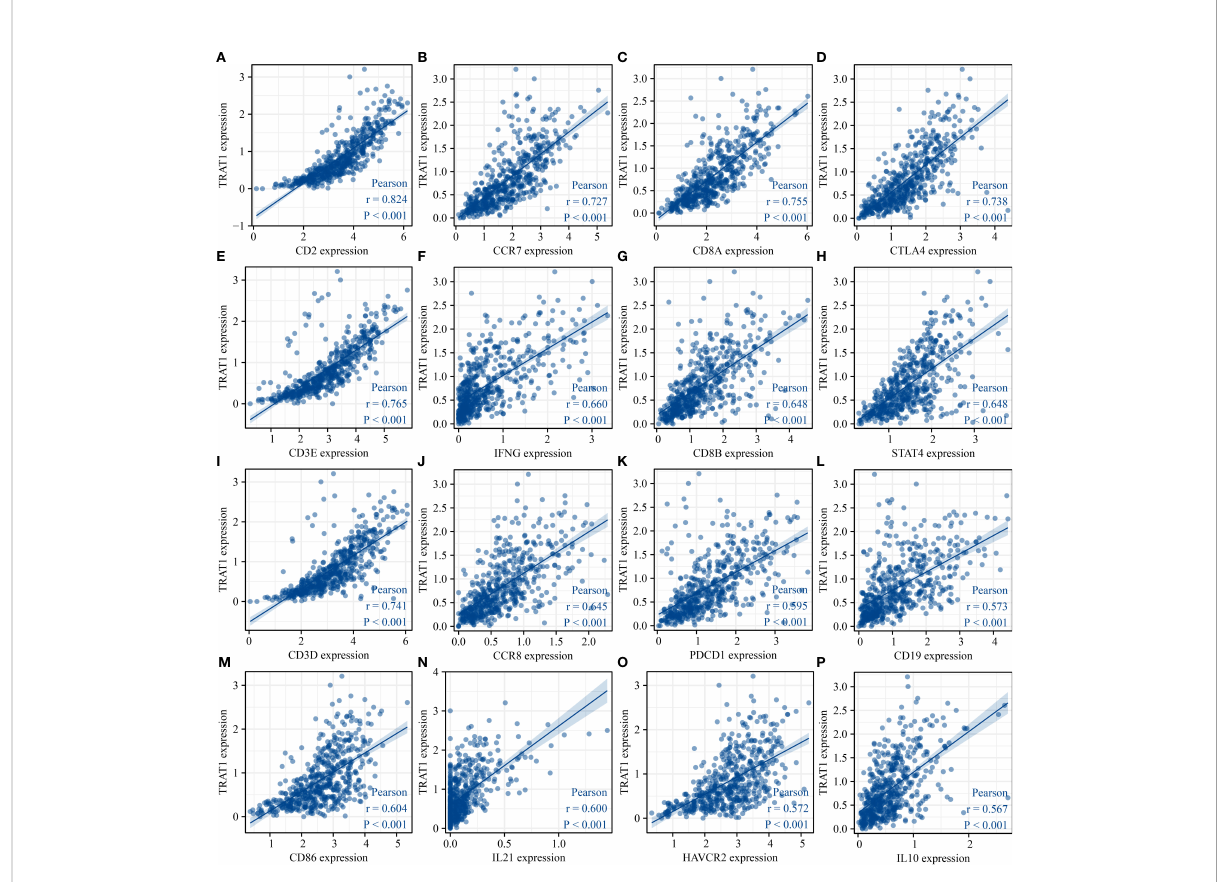
FIGURE 10 TRAT1 expression was signi fi cantly correlated with the levels of immune cell markers in LAC tissues. (A) CD2; (B) CCR7; (C) CD8A; (D) CTLA4; (E) CD3E; (F) IFNG; (G) CD8B; (H) STAT4; (I) CD3D; (J) CCR8; (K) PDCD1; (L) CD19; (M) CD86; (N) IL21; (O) HAVCR2; (P) IL10. LAC, lung adenocarcinoma.